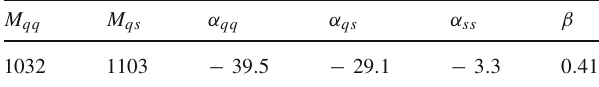
Table 2 Model parameters. The diquark masses M qq , M qs and the coefficients α qq , α qs , α ss are in MeV. The coefficient β is in fm − 3